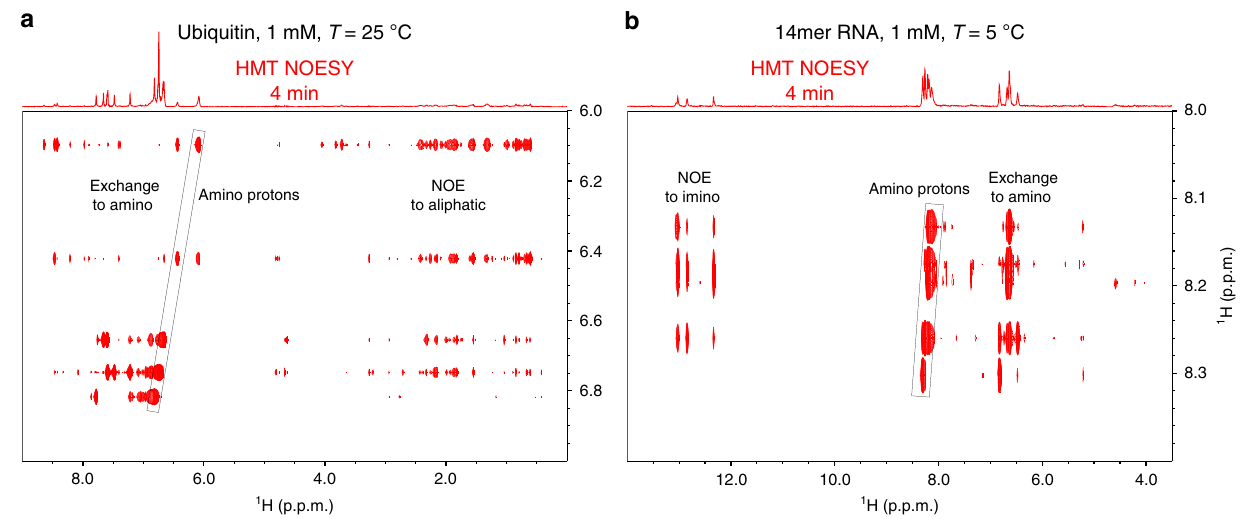
Fig. 5 Targeting amino protons with HMT NOESY. a Ubiquitin sample. b 14mer RNA in Fig. 3. The spectrum in a was acquired with 12 loops and 80 ms per loop, whereas in b a 600 ms long saturation pulse was used instead. The strongest correlations correspond to exchange and NOE cross-peaks to aliphatic and amino protons respectively; notice in the protein and the RNA, however, interesting amide → imino cross-peaks emerge as well. Spectra were acquired at 1 GHz using a Bruker Avance Neo console equipped with a TCI